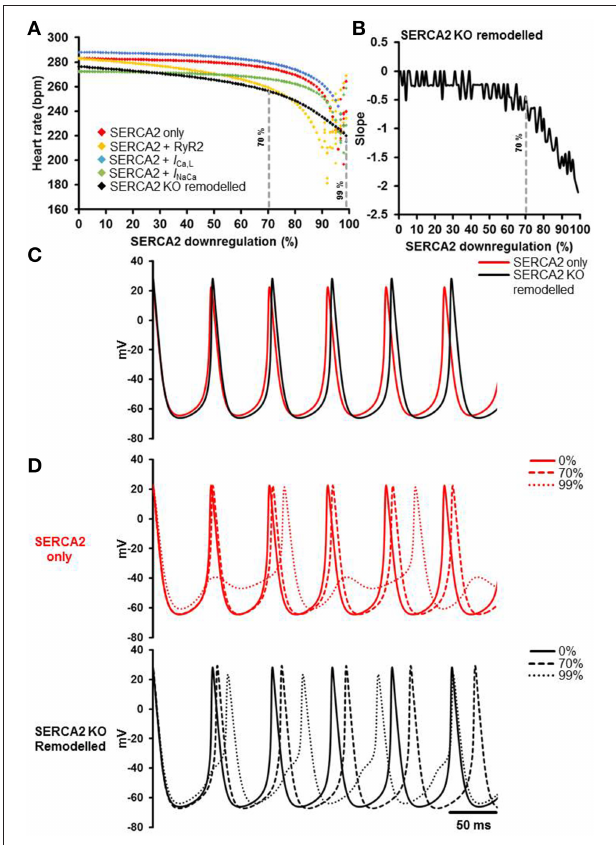
FIGURE 8 | Simulation of the effects of SERCA2 downregulation on the sinus node action potential. (A) Relationship between SERCA2 downregulation (0–99% reduction) and heart rate (bpm) under various conditions. Red symbols represent heart rates with changes to SERCA2 only (i.e., with all other parameters unchanged). Yellow, blue and green symbols represent introduction of changes to RyR2 (proportional to SERCA2), I Ca , L (1.3 fold increase), and I NaCa (2 fold increase), respectively. The combined effect of all changes is represented in black (SERCA2 KO remodeled). (B) Slope of the SERCA2 KO remodeled curve. (C) Action potential profiles of SERCA2 only (red) and SERCA2 KO remodeled (black) at 0% SERCA2 downregulation are shown. (D) Typical action potential profiles under SERCA2 only in red (top) and SERCA2 KO remodeled in black (bottom) are shown. Solid, dashed and dotted lines represent 0, 70, and 99% SERCA2 downregulation respectively. Modeling data generated by